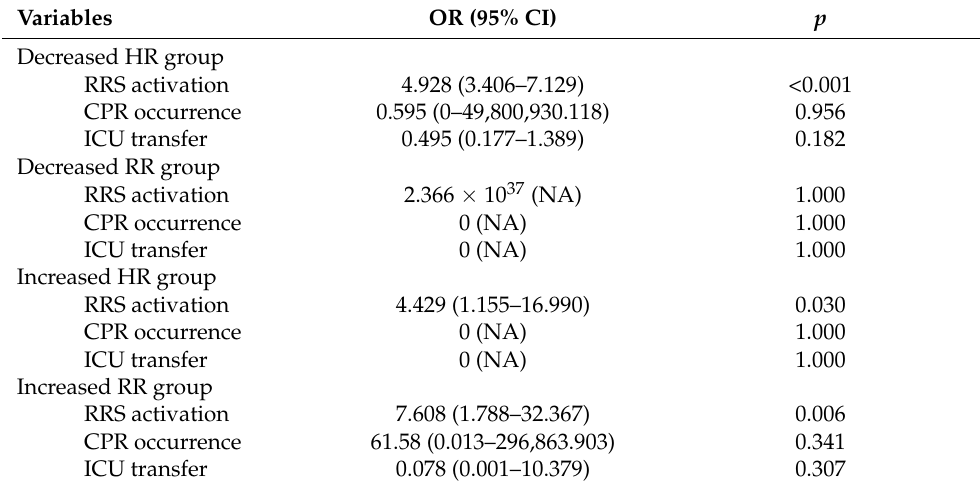
Table 2. Analysis of the association of critical event occurrence for each group.